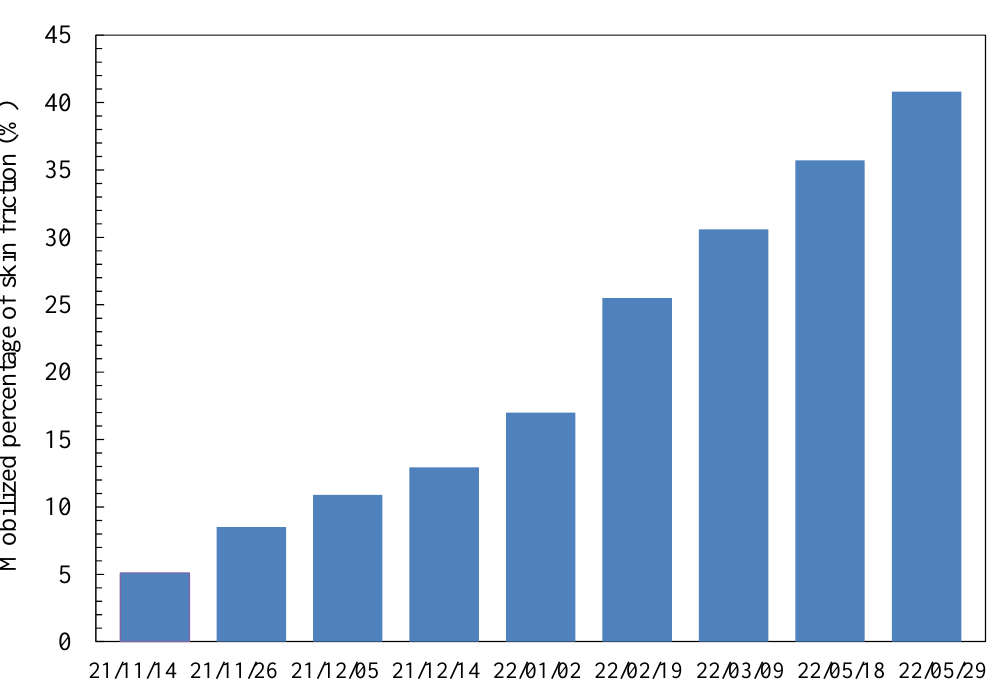
Figure 17. Mobilized percentage of skin friction.